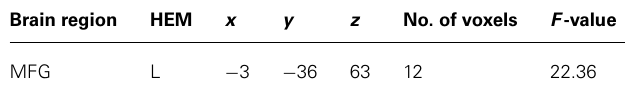
Table 4 | Significant activation clusters for the